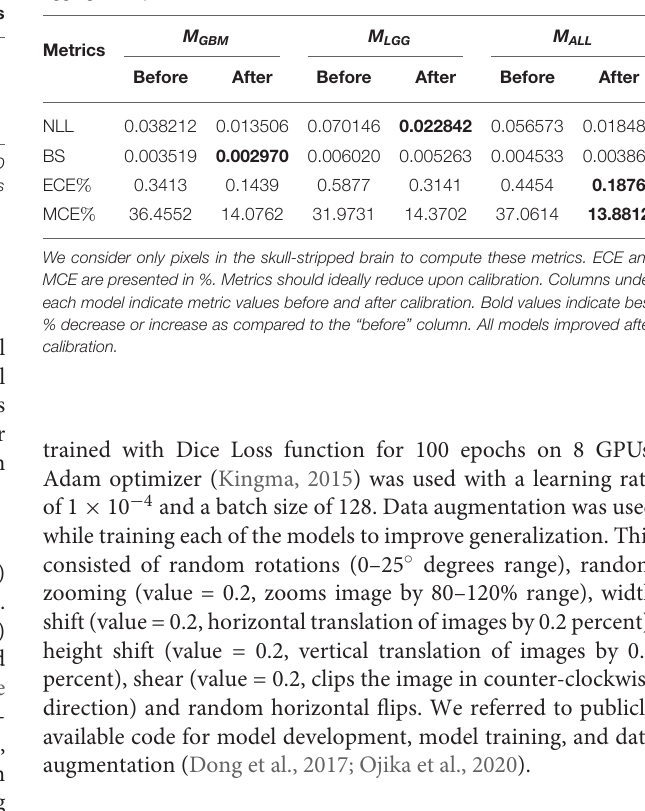
TABLE 2 | We first compute calibration metrics on a patient-level, then aggregated by mean.